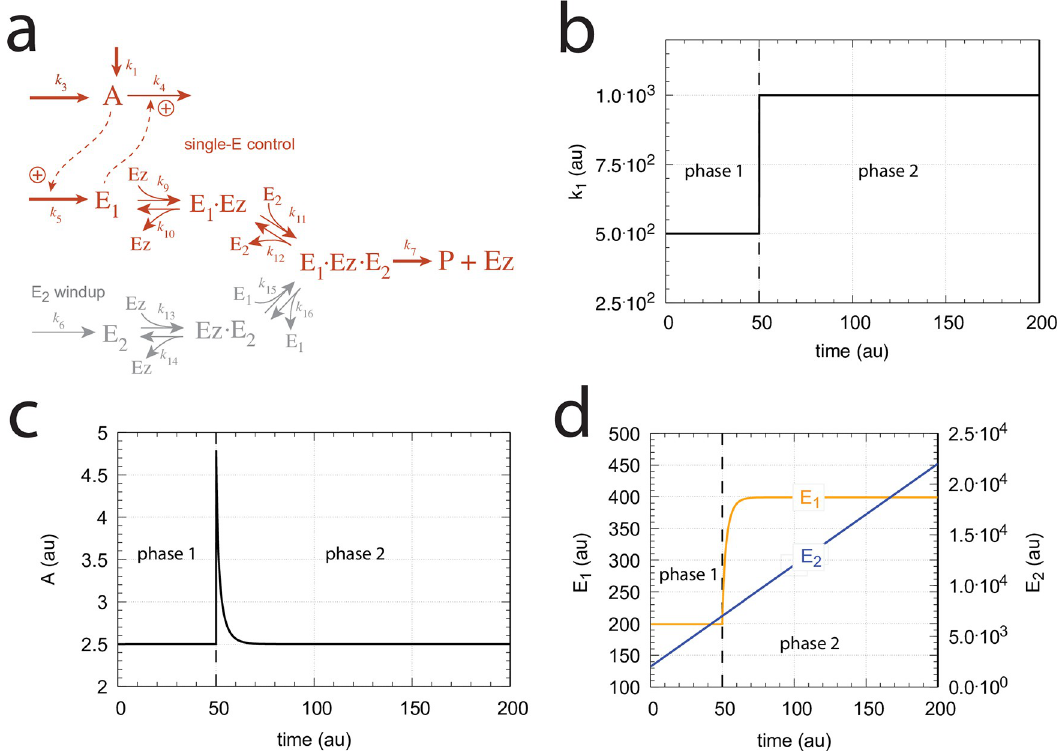
Fig 31. Example of the m5 feedback loop with E 1 and E 2 being removed by a random-order ternary-complex mechanism working in single-E control mode. (a) Scheme outlined in red shows part of the network participating in the control of A . (b) Step- wise change of k 1 from 500.0 to 1000.0 at time t = 50.0. (c) Homeostatic response of A , i.e. the controller defends its set-point (=2.5) defined by Eq 99. (d) Change of E 1 and wind-up of E 2 . Rate constants as in Fig 29, except that k 6 =200. Initial concentrations: A 0 =2.5, E 1,0 =199.2, E 2,0 =2.0 × 10 3 , Ez 0 =4.54 × 10 − 11 , (E 1 � Ez) 0 =4.51 × 10 − 12 , (E 1 � Ez � E 2 ) 0 =9.995 × 10 − 7 , (EzE 2 ) 0 =4.56 × 10 − 10 .